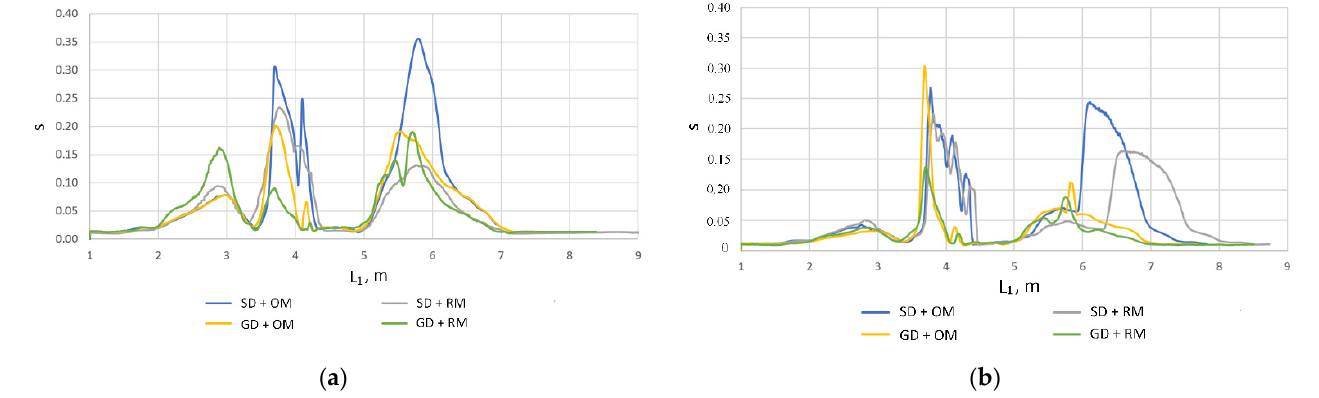
Figure 15. The maximum value from the course of road wheel skidding during the simulation when the vehicle model was driven through the ditch at the maximum value of the coefficient of adhesion ϕ = 0.3 ( a ) and ϕ = 0.7 ( b ): GD—gear-type flow divider, SD—spool-type flow divider, OM—orbital motor, RM—radial piston motor.